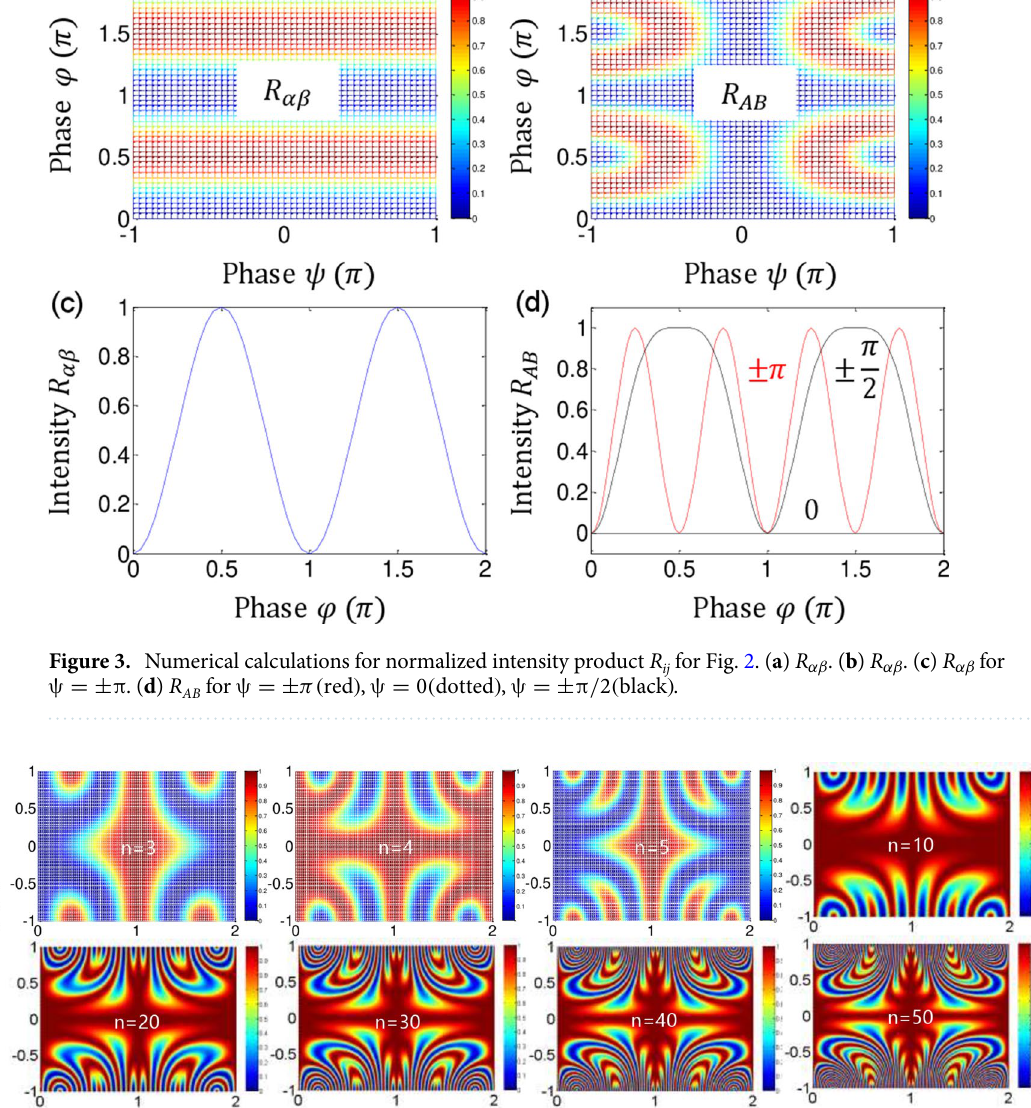
Figure 4. Numerical calculations for the output field intensity I (